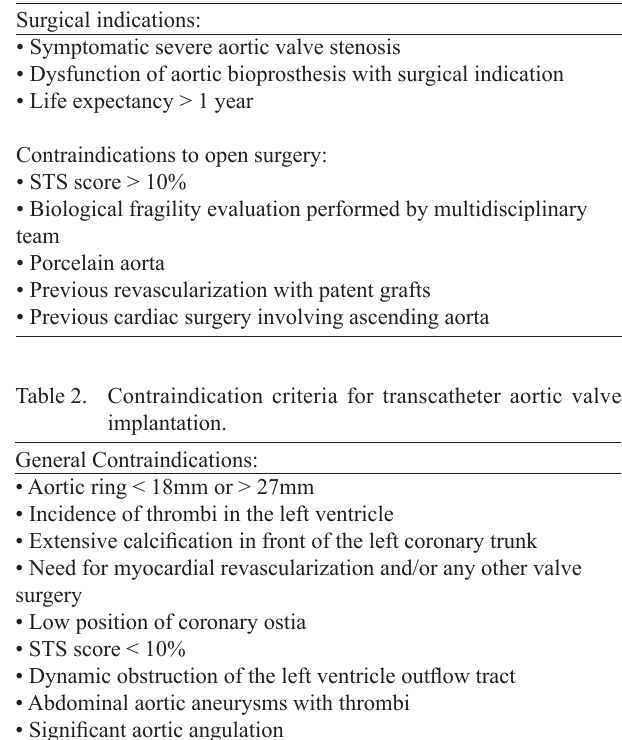
Table 1. Indication criteria for transcatheter aortic valve implantation.